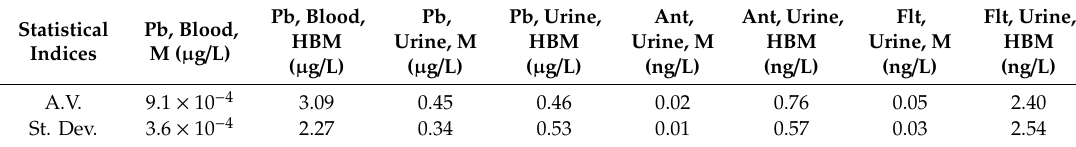
Table 7. Comparison between contaminant concentrations estimated by MERLIN software (M) and measured concentrations reported in the Human Bio-monitoring study (HBM) in the E group: average value (A.V.) and standard deviations (St. Dev.). Pb = Lead, Ant = Anthracene, Flt = Fluoranthene. Statistical